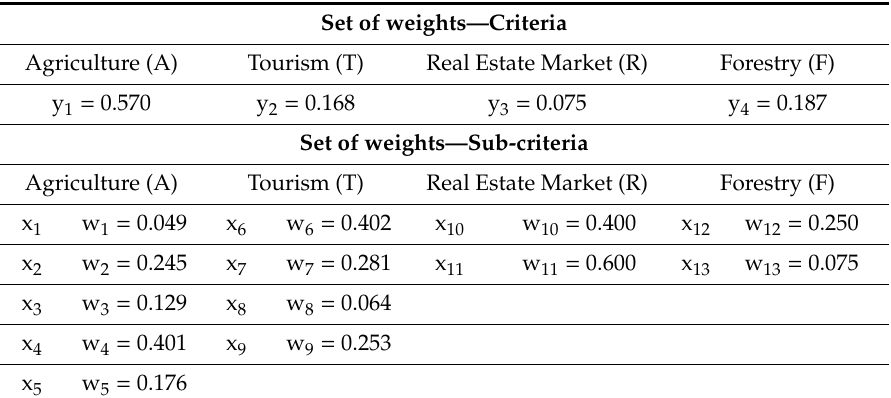
Table 3. The set of weights to assess the importance of the landscape economic indicators. Set of weights—Criteria Agriculture (A) Tourism (T) Real Estate Market (R) Forestry (F) y 2 = 0.168 y 3 = 0.075 y 4 = 0.187 Set of weights—Sub-criteria Agriculture (A) Tourism (T) Real Estate Market